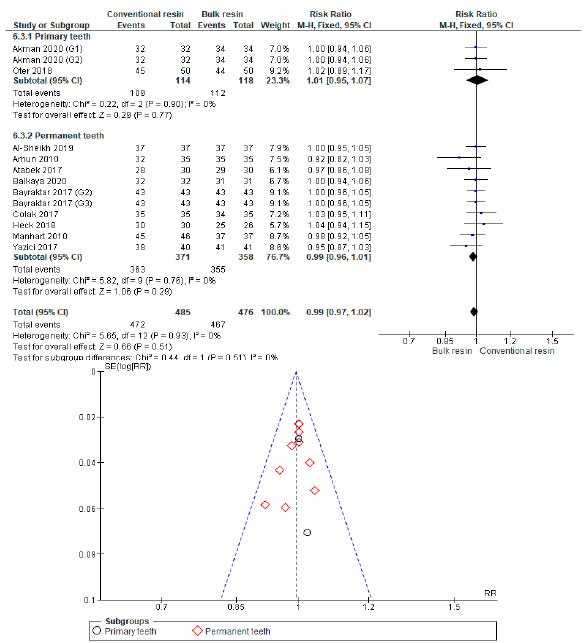
Figure A28. Adequate Color Stability and Translucency: Conventional Resin versus Bulk Resin According to Type of Teething.